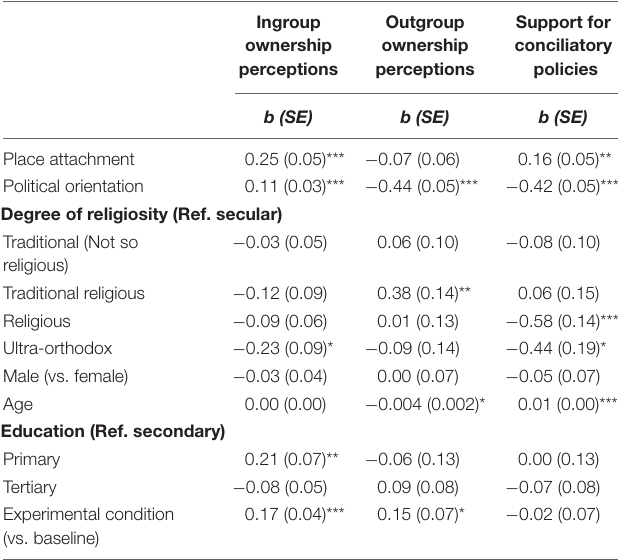
TABLE 3 | Unstandardized results of the control variables of the structural equation analysis explaining support for conciliatory policies ( N =